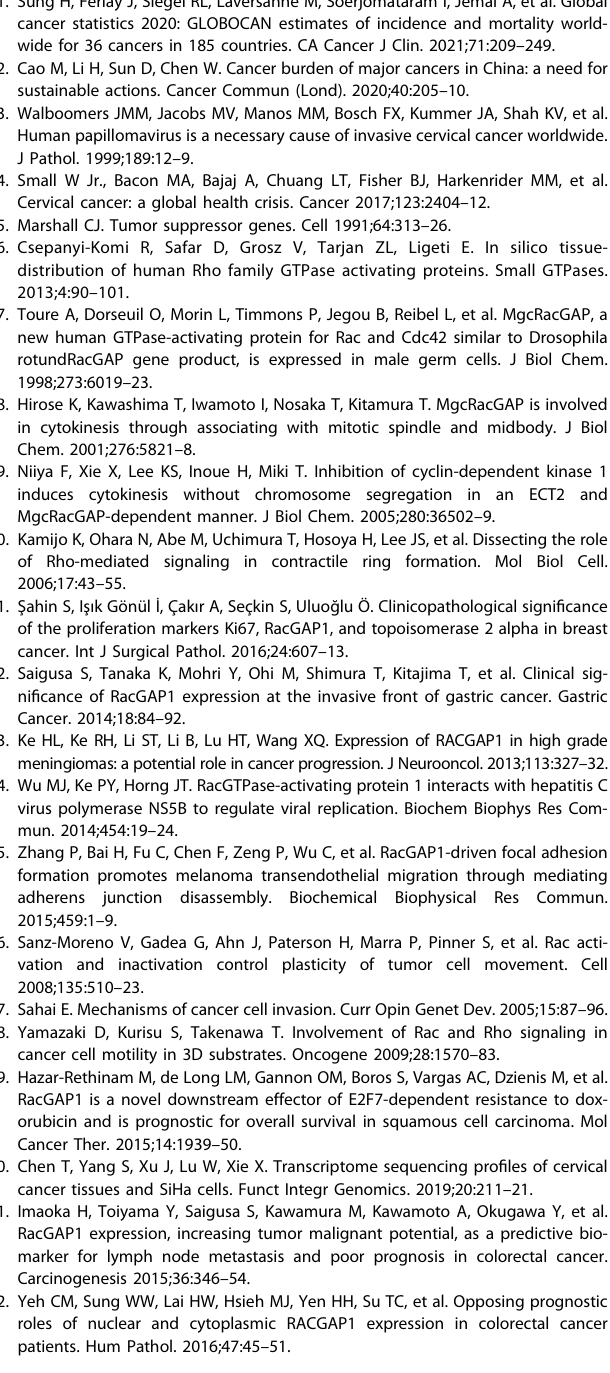
Fig. 6 RacGAP1 activated AP-1 via miR-192 and p-JNK. A Microarray analysis of Hela cell RacGAP1 KD compared with NC. B KEGG pathway enrichment analyses of DEGs from our cohort and GSE108422. C Detection of RhoA activity and ROCK1 expression in RacGAP1 knockdown or -overexpressing CC cells. RacGAP1 was positively correlated with RhoA and ROCK1 ( R = 0.49 and R = 0.68, p < 2.2e-16). D Changes in the expression of the genes after RacGAP1 knockdown or overexpressed in CC cells were detected by Western blot. E KEGG pathway enrichment analyses of miR-192 target genes and DEGs from GSE69990. F Western blot analysis was used to detect the protein expression after cells were transfected with miR-192 inhibitor and mimics. G Western blot analysis of the protein expression of the rescue experiment in CC cells. H Western blot analysis of the protein expression changes of CC cells treated with SP600125. I Pattern diagram of RacGAP1 effect to cervical cancer. RacGAP1 Rac GTPase-activating protein 1, JNK c-Jun N-terminal kinase, MMP7 matrix metallopeptidase 7, ROCK1 Rho-associated coiled-coil containing protein kinase 1. The data were presented as means ± SEM. * p < 0.05, ** p < 0.01, *** p < 0.005, **** p <